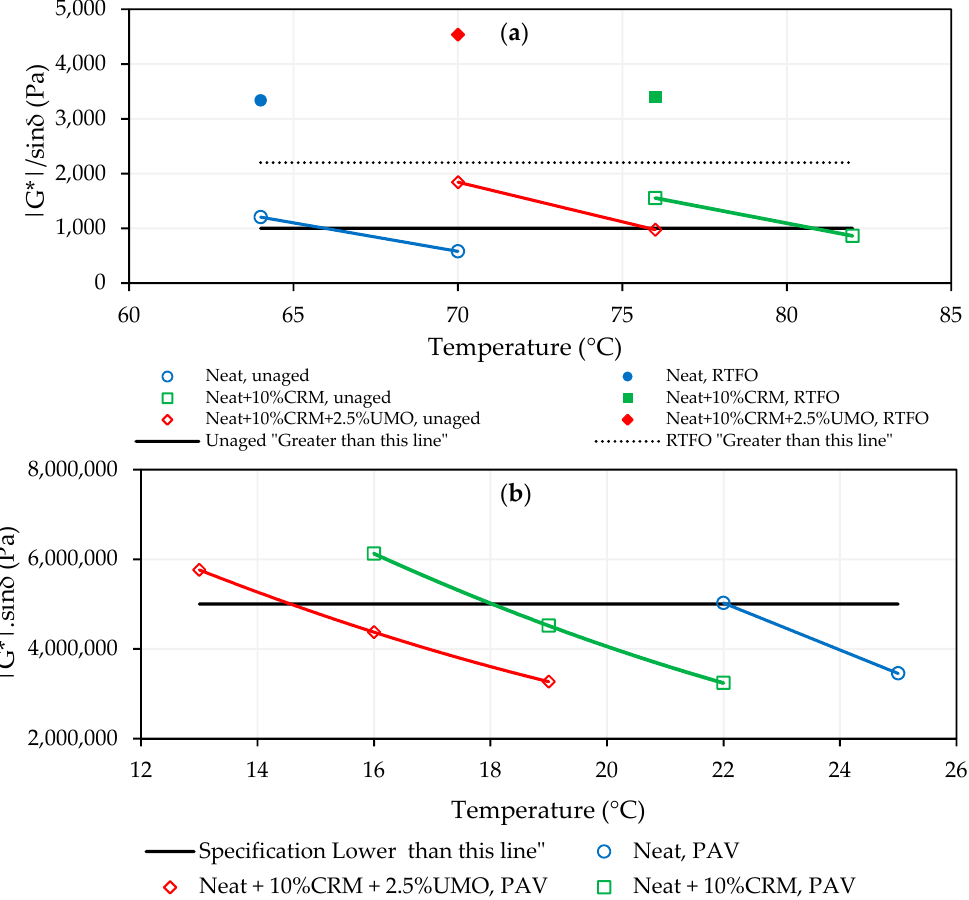
Figure 3. Rheological properties for PG 64-22 neat and modified asphalt binders based on: ( a ) DSR for unaged and RTFO-aged; ( b ) DSR for PAV-aged, interacted at 190 °C—50 Hz—62 min.